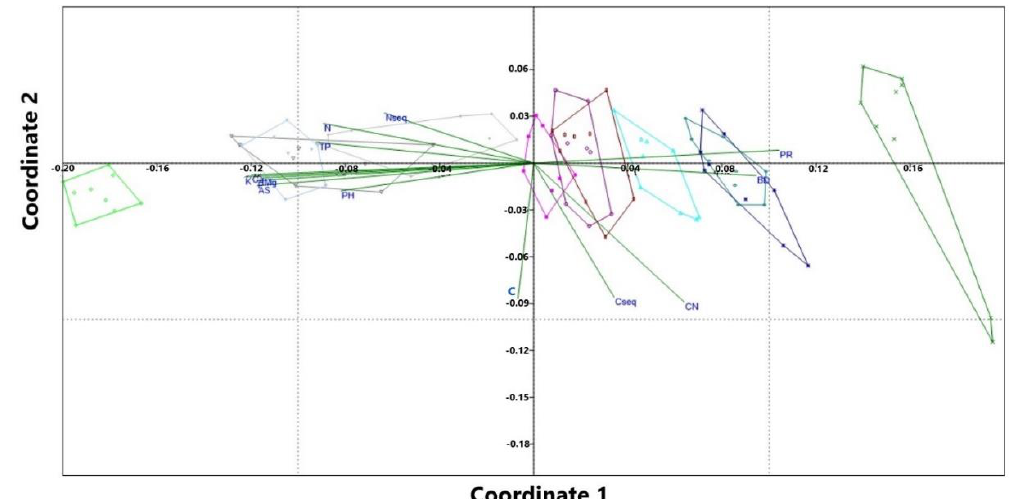
Figure 3. nMDS analysis of different soil physical properties in different mulching or no-mulching treatments for the soil layer 5-10 cm. UND, undisturbed (control), light green polygon; LM6.2, litter mulch level of 6.2 Mg ha − 1 , light grey polygon; LM12.2, litter mulch level of 12.2 Mg ha − 1 , dark grey polygon; LM18.6, litter mulch level of 18.6 Mg ha − 1 , light blue polygon; SM3.8, straw mulch level of 3.8 Mg ha − 1 , light purple polygon; SM7.6, straw mulch level of 7.6 Mg ha − 1 , dark purple polygon; SM11.4, straw mulch level of 11.4 Mg ha − 1 , red polygon; SDM11.1, sawdust mulch level of 11.1 Mg ha − 1 , bright light blue polygon; SDM22.2, sawdust mulch level of 22.2 Mg ha − 1 , blue polygon; SDM33.3, sawdust mulch level of 33.3 Mg ha − 1 , dark blue polygon; UNT, untreated treatment, dark green polygon.